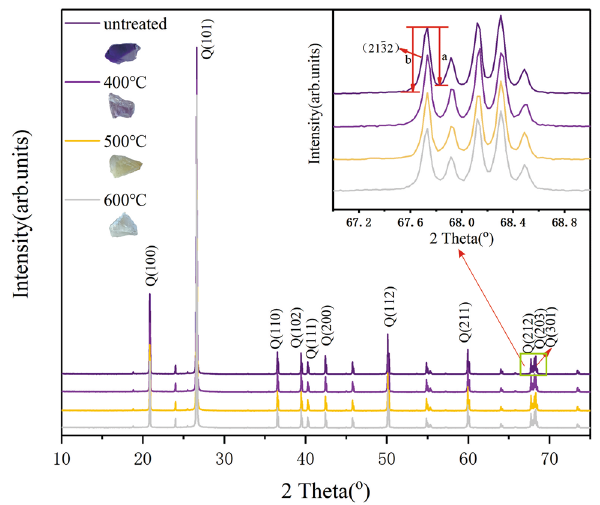
Figure 2. X-ray diffraction patterns of four samples under different temperature, the top right is the ( 2132 ) diffraction peak of quartz, a and b values of crystallinity index CI. The figure was drawn using the OriginPro 2017C Beta b9.4.1.268 (https ://www.Origi nLab.com).